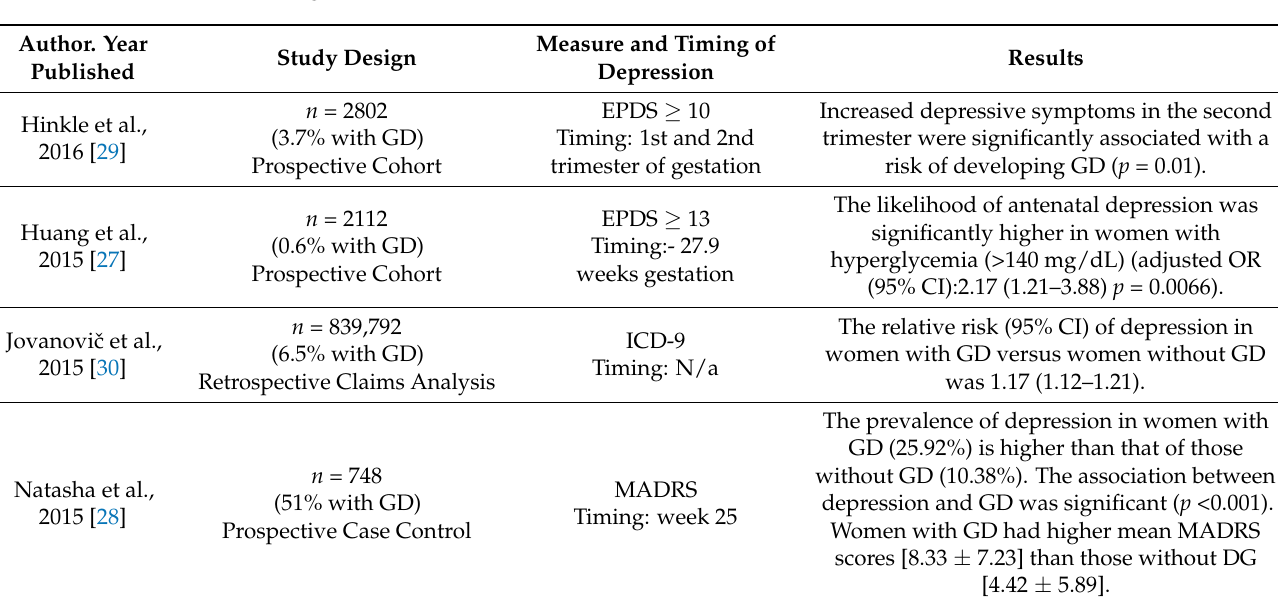
Outcomes of studies evaluating depression during pregnancy in women with gestational